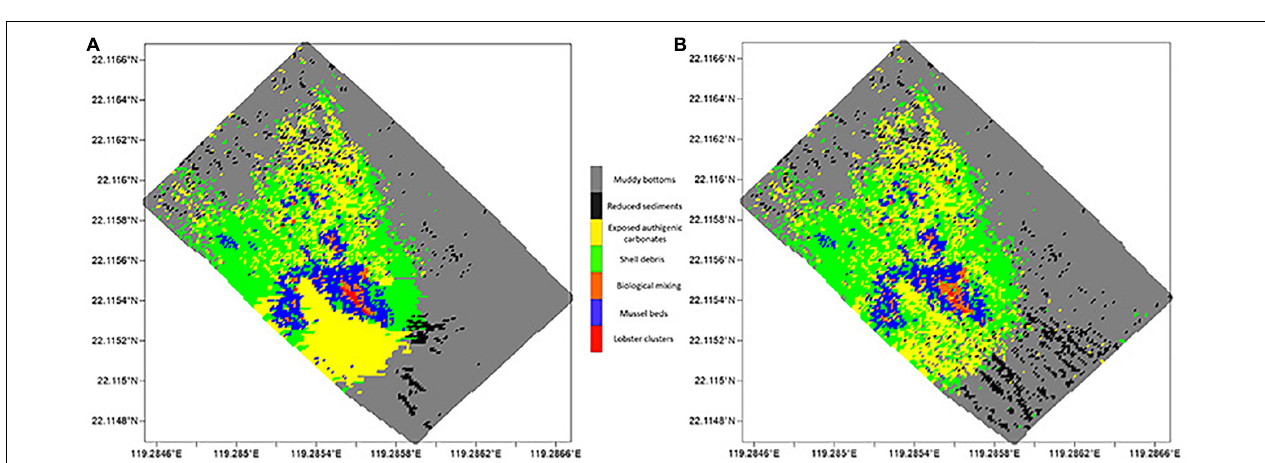
FIGURE 9 | Spatial distribution of different substrates, with (A) manual counting and (B) model identification, respectively.